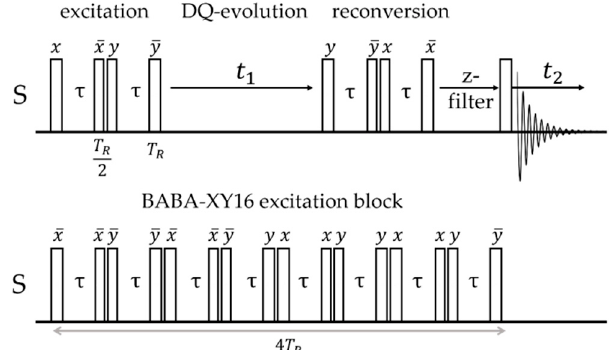
Figure 12. Top: 2D double quantum/single quantum NMR spectroscopy with back-to-back ( BaBa ) excitation. All pulses have a 90° flip angle. Bottom: BaBa-XY16 excitation for increased efficiency and excitation bandwidth. The symbols x and y denote pulse phases.